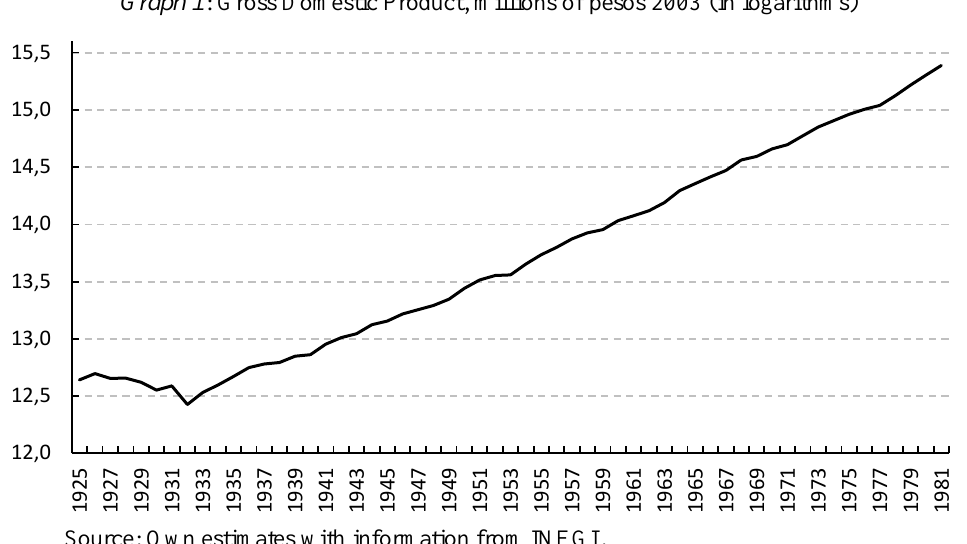
Source: Own estimates with information from